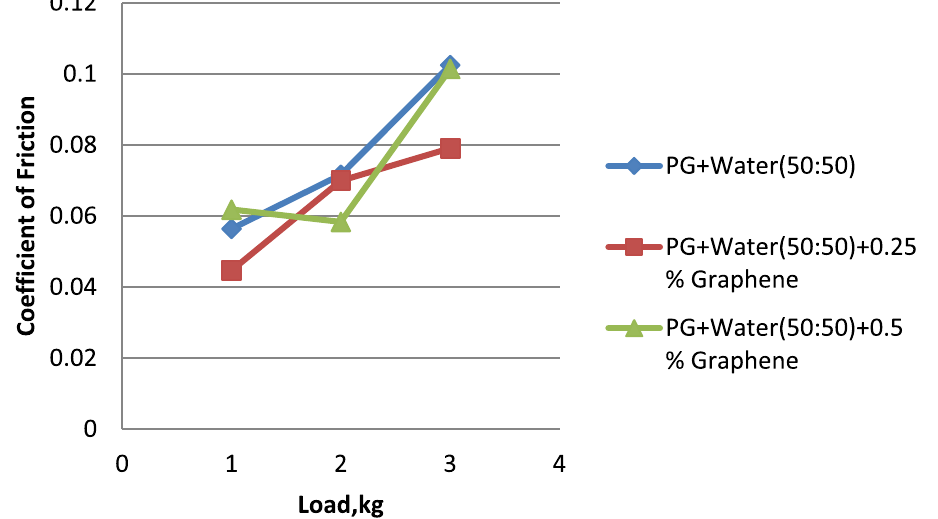
Figure 9. Load vs. coefficient of friction for propylene glycol (50:50).